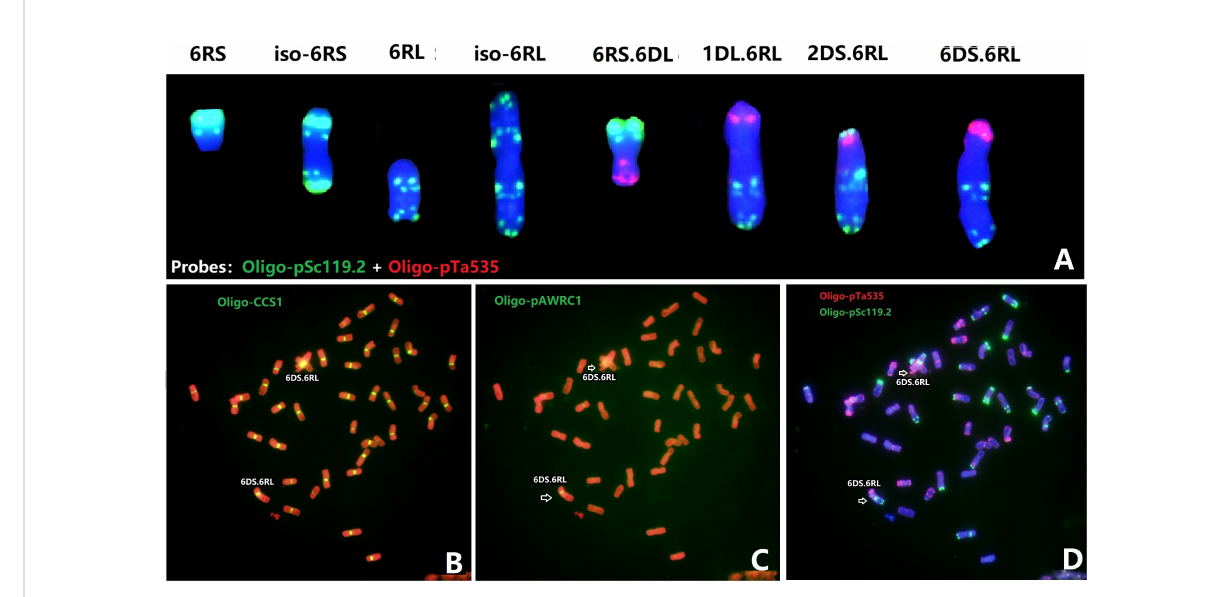
FIGURE 2 Sequential ND-FISH of the chromosome variations of 6R (A) and line R23 with T6DS.6RL in a MY11 background (B-D) . The different types of 6R variations and wheat-6R translocations are shown by ND-FISH with probes Oligo-pSc119.2 and Oligo-pTa535 (A) . The centromeric probes Oligo-CCS1 (B) and Oligo-pAWRC1.1 (C) , and Oligo-pSc119.2 + Oligo-pTa535 (D) , were used to show that the centromere in T6DS.6RL contains both wheat and rye